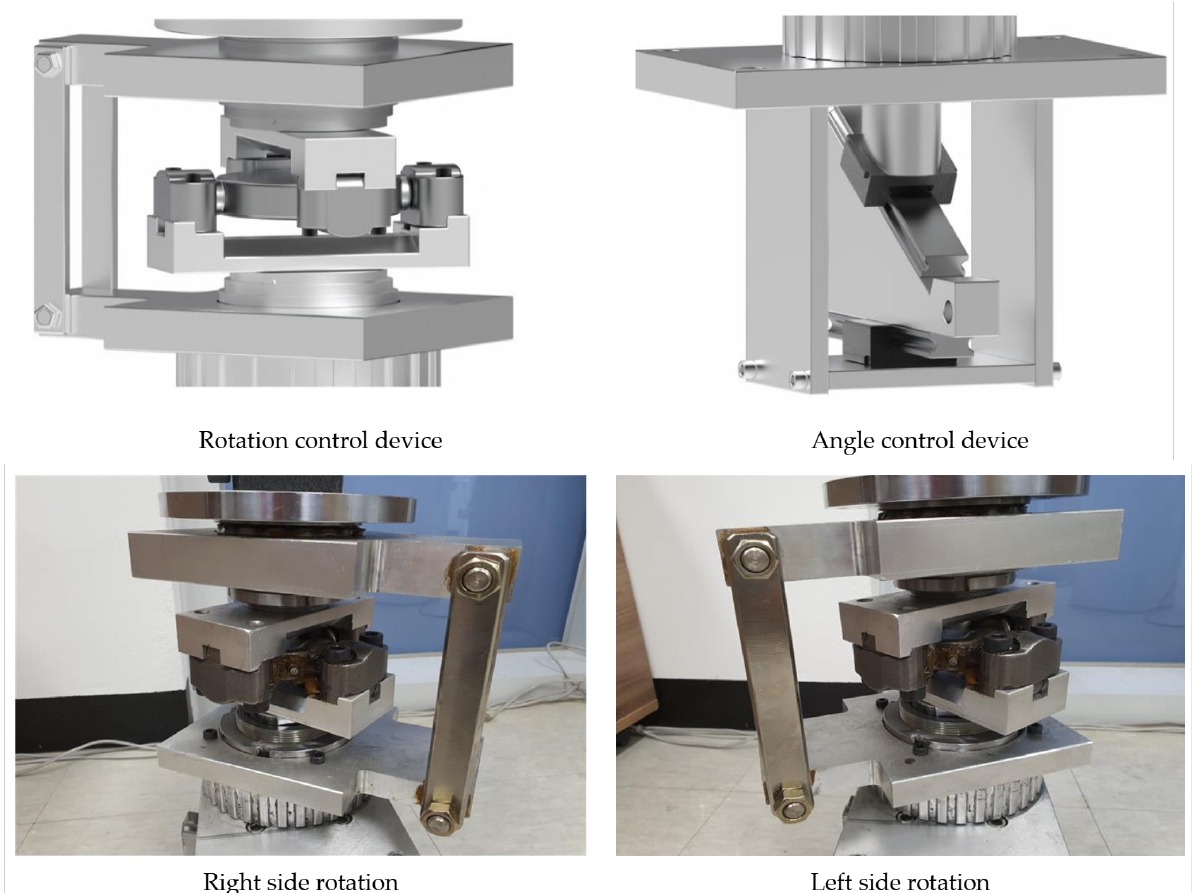
Figure 11. Rotation mechanism on the motor device illustrated.